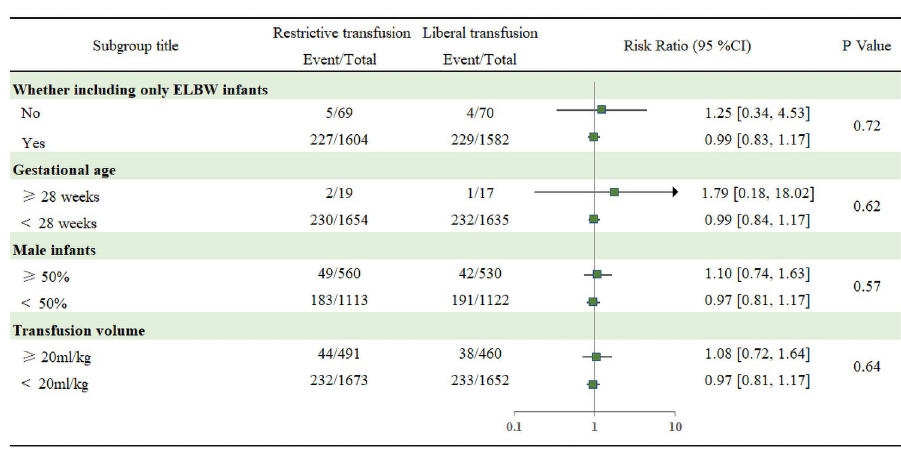
Fig 3. Subgroup analysis for all-cause mortality. VLBW: Very low birth weight; ELBW: Extremely low birth weight.